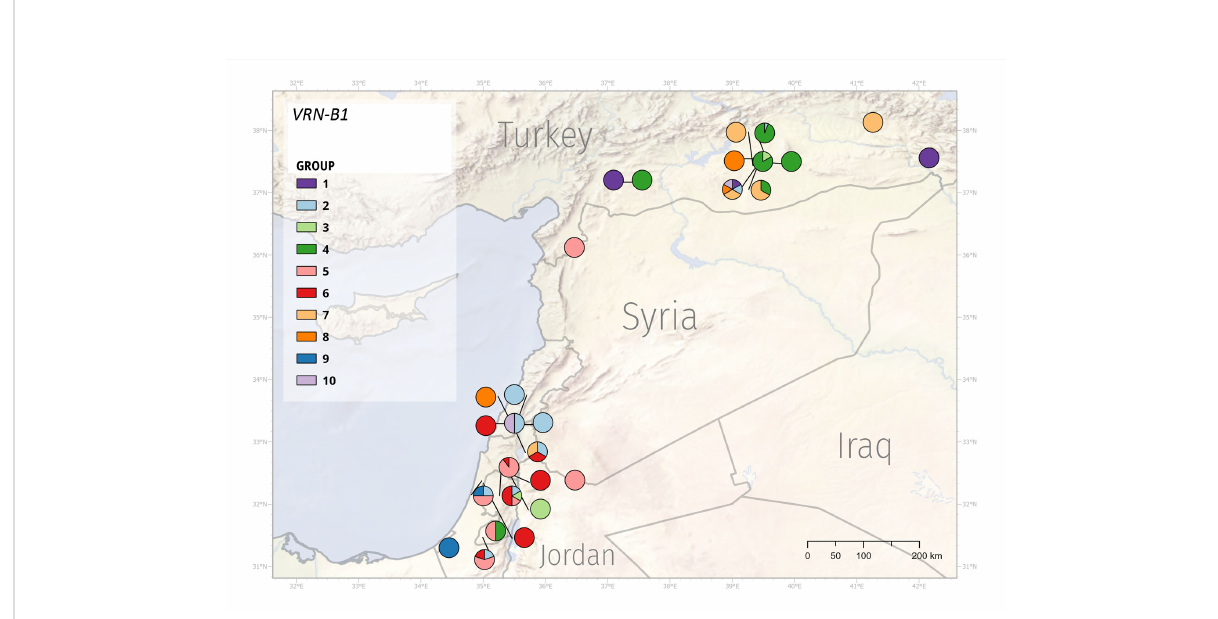
FIGURE 7 Geographic distribution of the VRN-B1 alleles. WEW genotypes formed 10 groups according to the VRN-B1